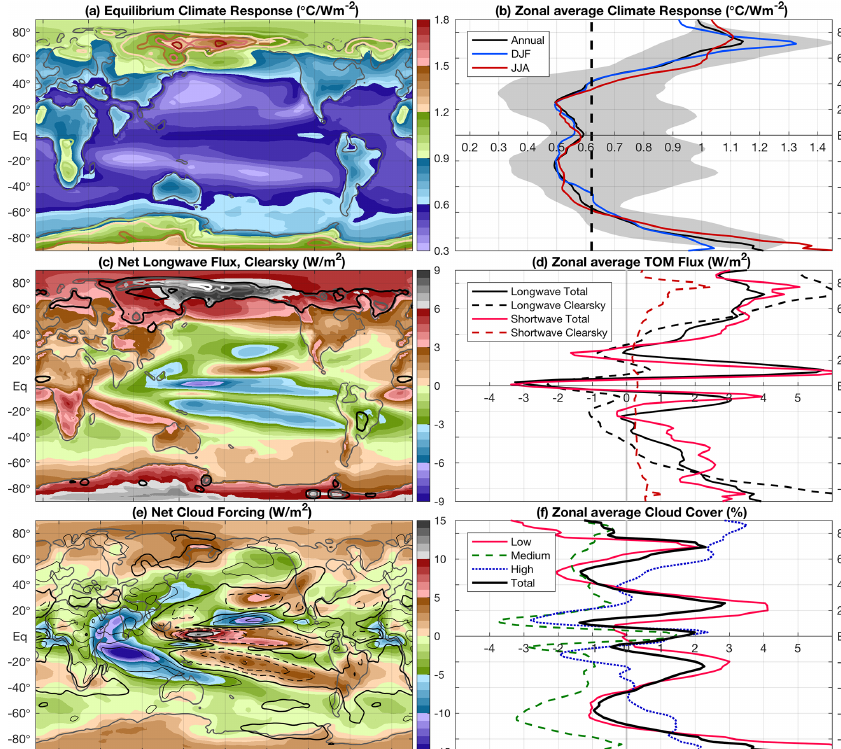
Figure 9. (a) Annual mean temperature response, normalised by the global average TOM forcing (in Wm − 2 ) of the 38Ma 4 × PIC compared to the 2 × PIC equilibrium climate with contours showing the winter season only (using the same colour scale). (b) Zonal average normalised temperature response; annual (black, shading for zonal variation), December–January–February (blue) and June–July–August (red). The (area-weighted) global average response (i.e. climate sensitivity) is 0.62 ◦ CW − 1 m 2 as indicated by the black dashed line. (c) Clear-sky component of the net longwave flux change at the TOM for 38Ma 4 × PIC vs. 2 × PIC, similar for the clear-sky shortwave flux in contours (black to white; 1, 2, 5, and 10Wm − 2 ). (d) Zonal average TOM flux change for longwave (black) and shortwave (red) fluxes, corresponding clear-sky components are shown using dashed lines. Note that longwave fluxes are defined positive upward while shortwave fluxes are positive downward. (e) Change in the total cloud forcing; longwave component (shading) and shortwave (contours every 5Wm − 2 ; solid positive and dashed negative, thick black line at 0Wm − 2 ). (f) Zonal average changes in cloud cover (in %) at low (solid red), medium (dashed green), high (dotted blue) and all (thick solid black) atmospheric levels.